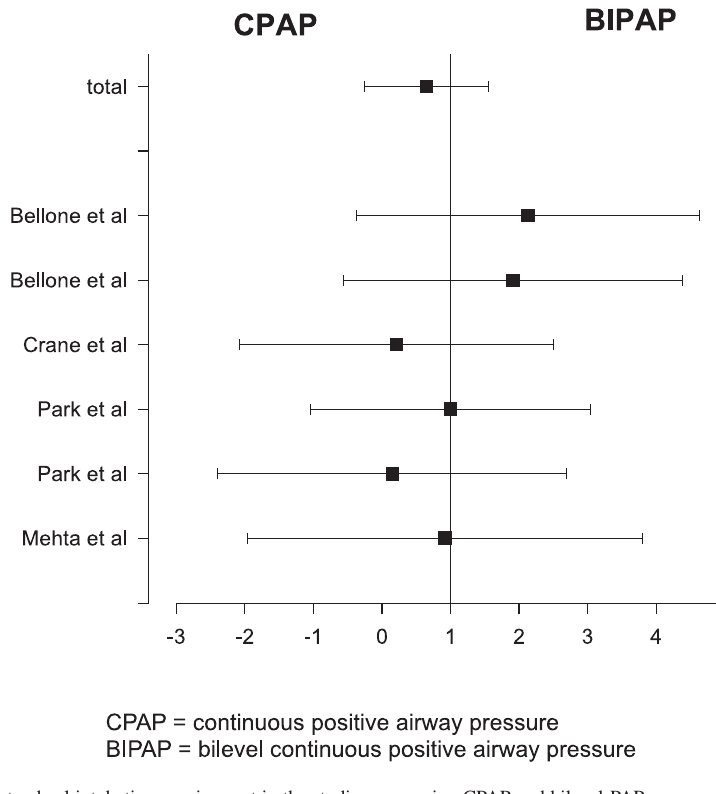
Figure 1 - ODDS ratio of endotracheal intubation requirement in the studies comparing CPAP and